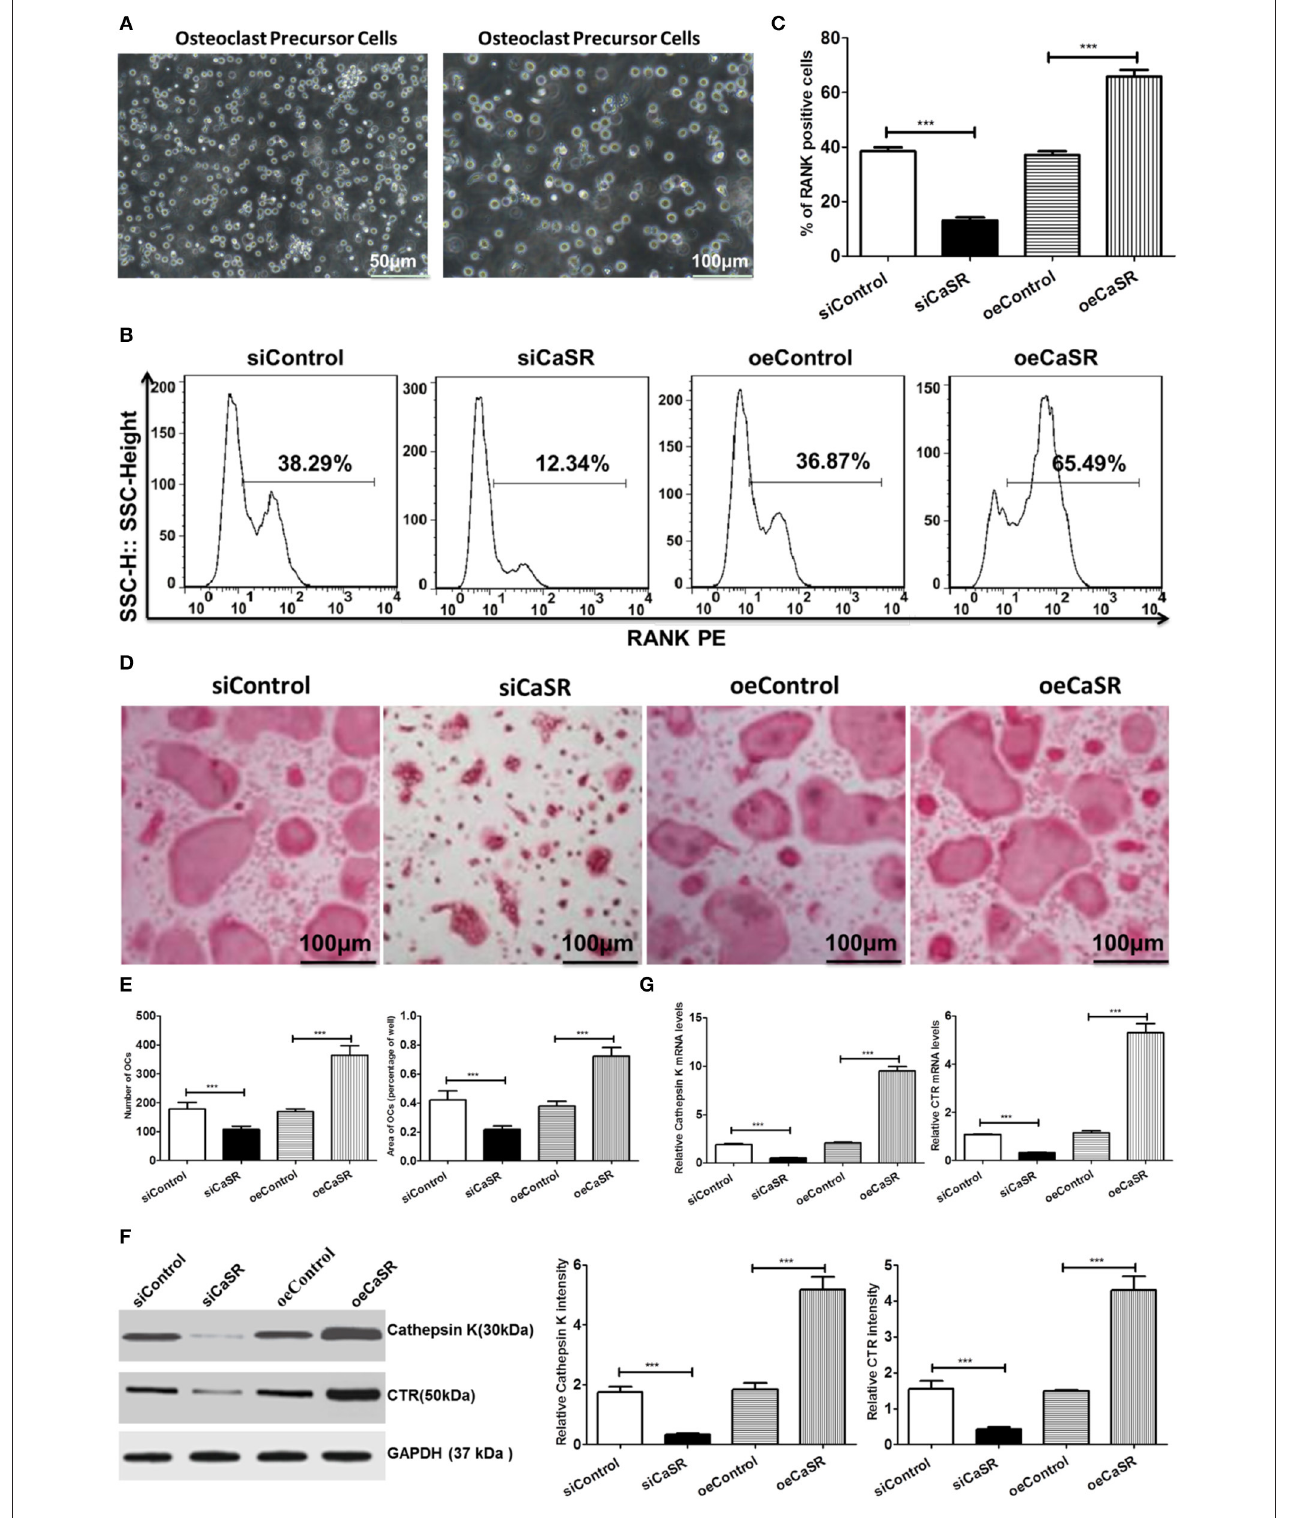
FIGURE 3 | Analysis of CaSR effects on OCs. (A) Isolation and identification of OC precursor cells. (B–E) Four groups of OC precursor cells were treated with CM from modified A549 cells co-cultured with macrophages to examine potential OC differentiation induction. Flow cytometry was used to detect expression of RANK-positive OCs. TRAP + multinucleated cells were counted using 400-fold microscope and TRAP-stained OC area was calculated using ImageJ software (NIH).